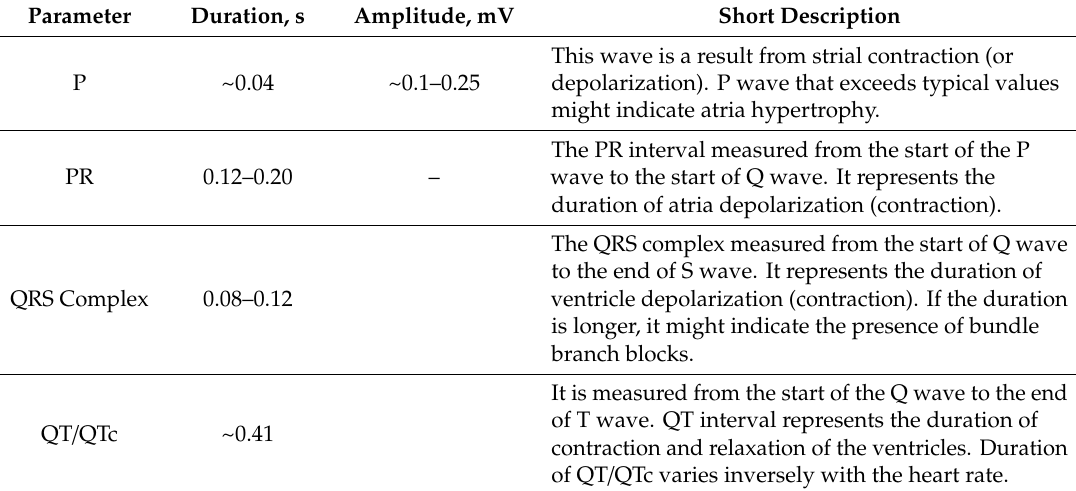
Table 3. Description of main parameters of electrocardiography (ECG) signal [75].